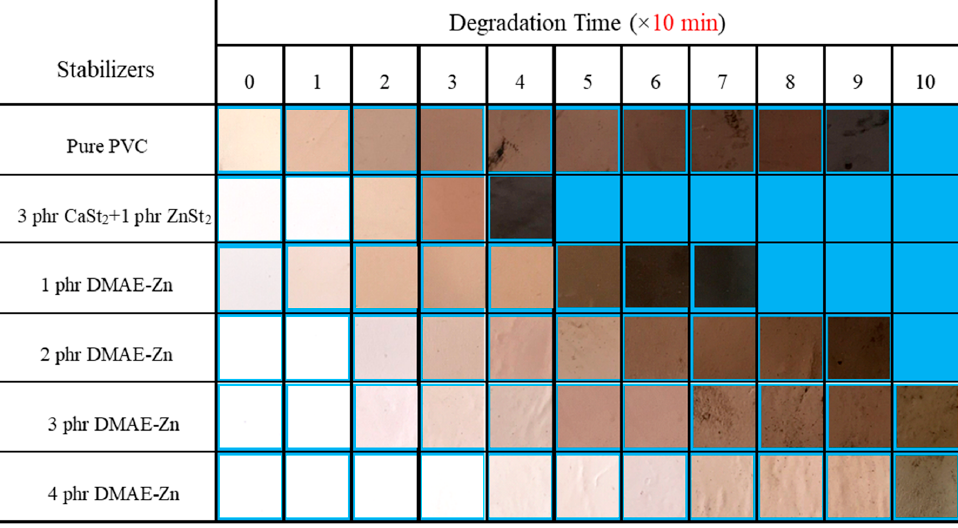
Figure 4. Color evolution of PVC samples with different thermal stabilizers at 180 °C .